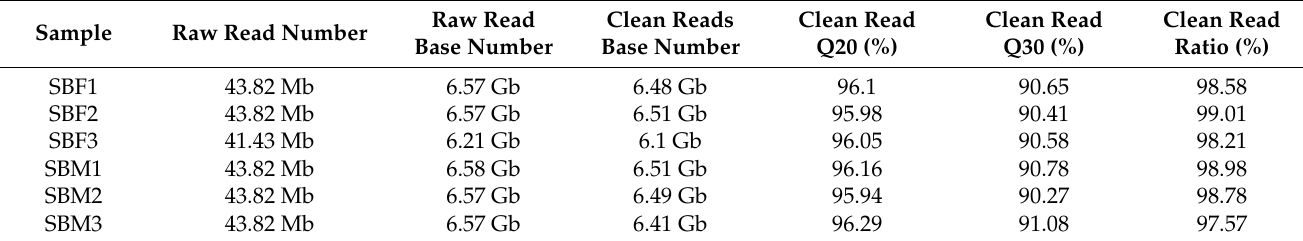
Table 1. Summary of the C. sacchariphagus transcriptome.